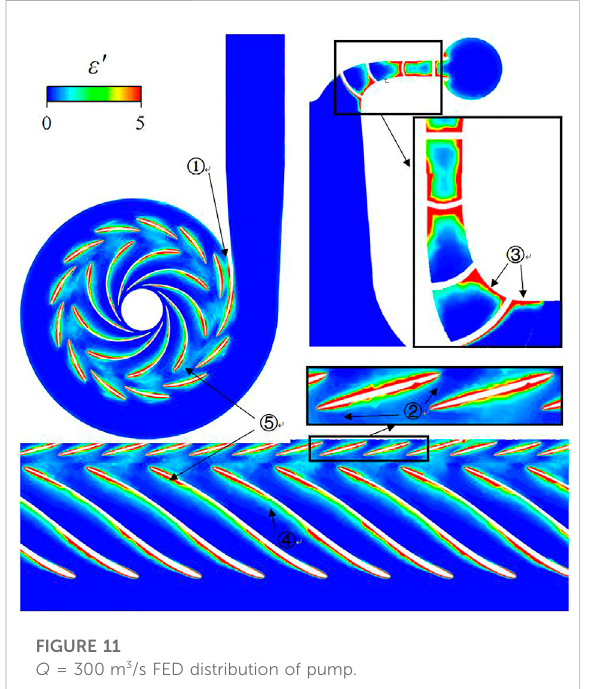
FIGURE 12 Q = 300 m 3 /s FED distribution of